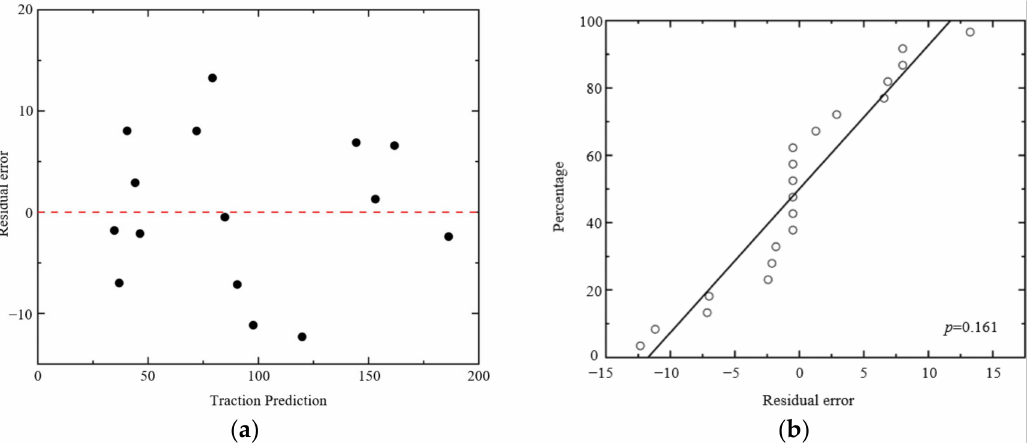
Figure 14. Analysis of residual error. ( a ) Scatterplot of the predicted values versus the residuals; ( b ) normal probability